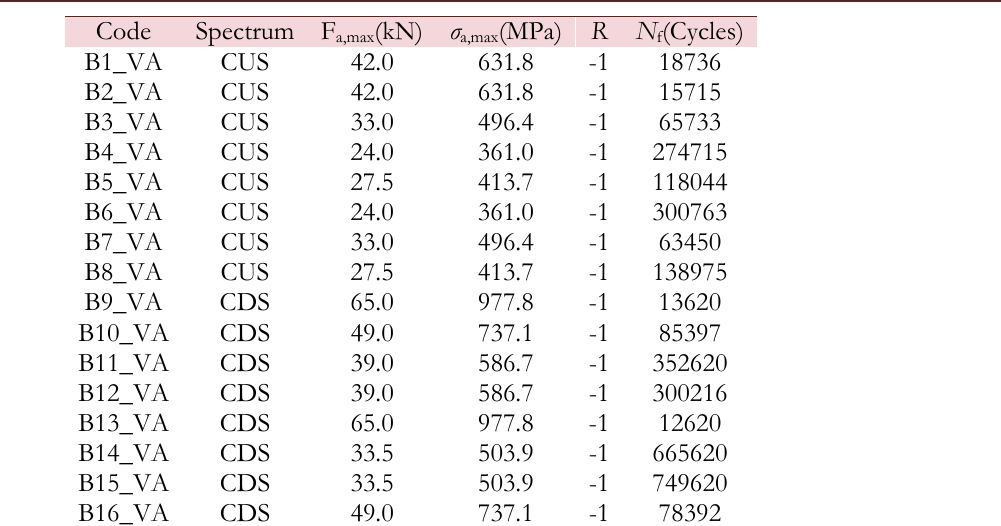
Table 4: Summary of the experimental results generated by testing the notched specimens with root radius equal to 3 mm under VA fatigue loading [3].